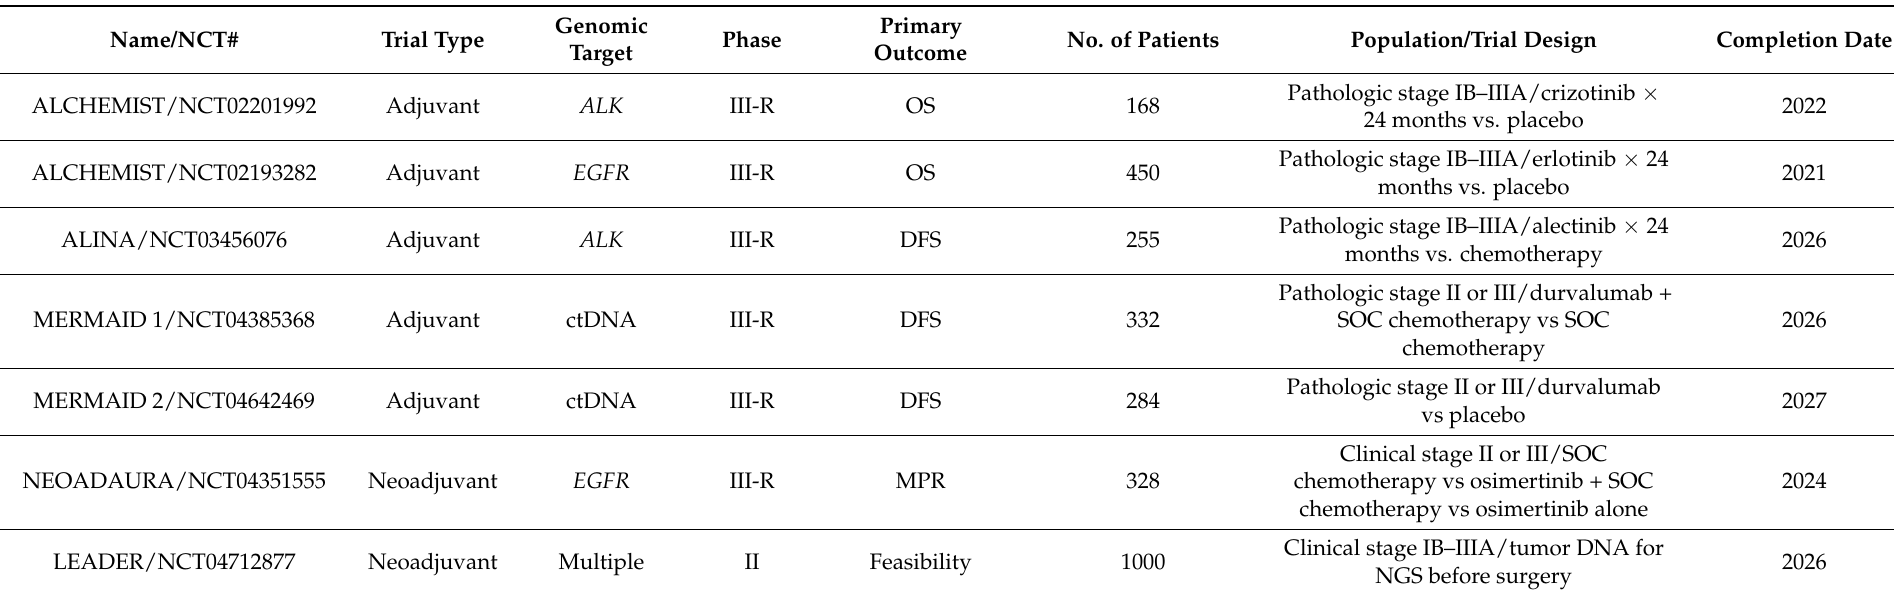
Table 2. NGS-driven adjuvant and neoadjuvant trials in patients with early-stage NSCLC undergoing surgical